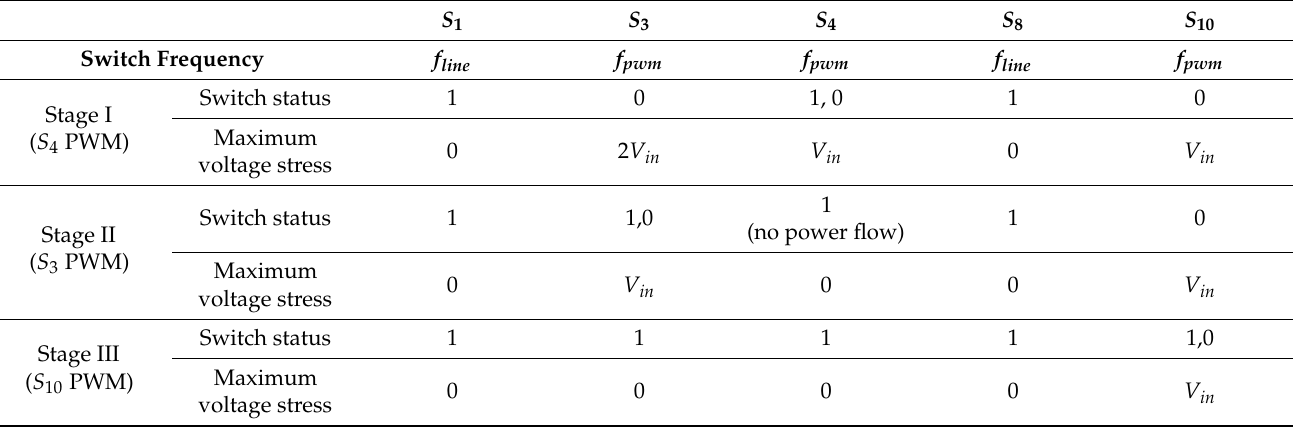
Table 2. Switch behavior of the proposed circuit and the corresponding maximum voltage stresses of switches at the positive half-cycle.